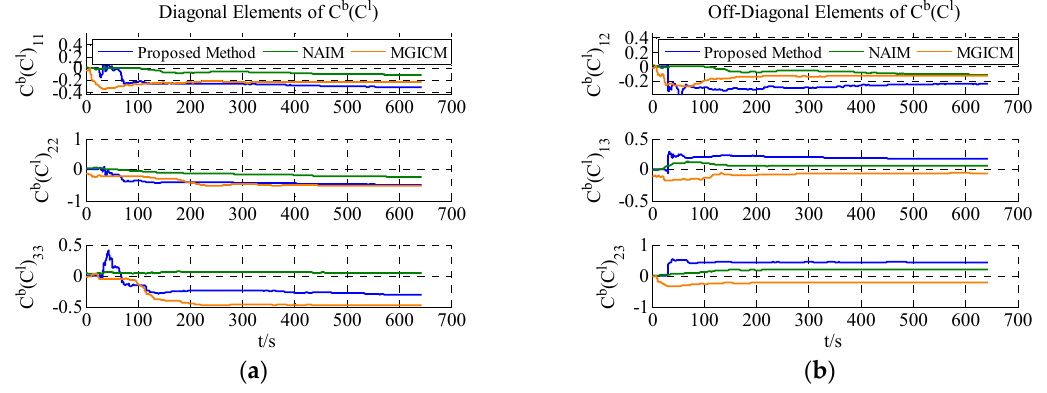
Figure 14. Estimation results of ADIS16488 ′ s magnetometer scale factors.